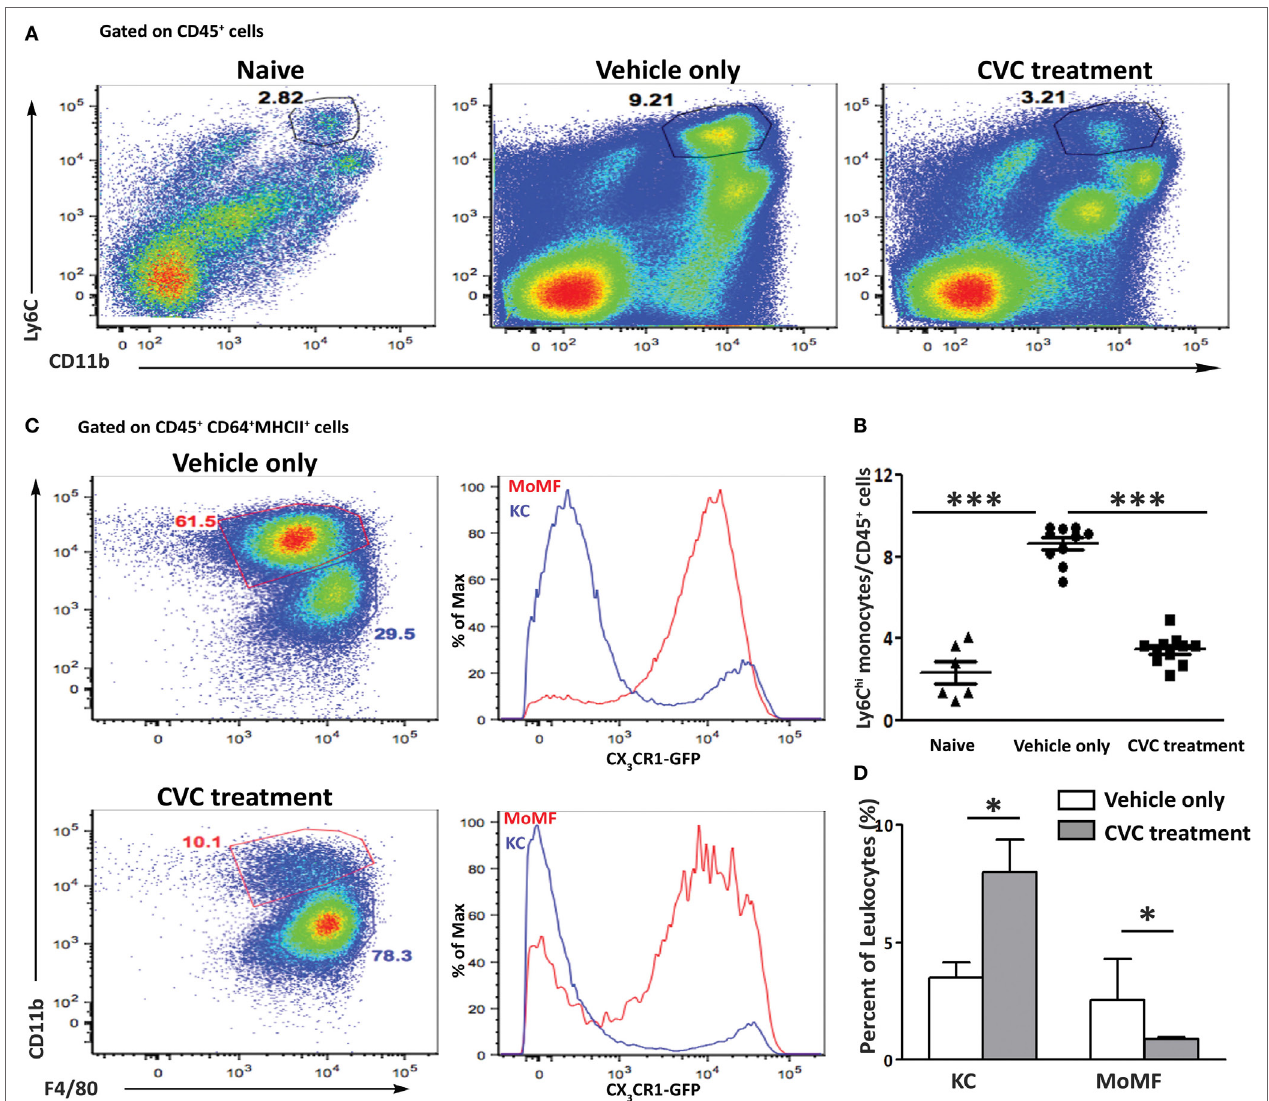
FigUre 4 | Reduced hepatic infiltration of monocyte-derived cell in CVC-treated mice subjected to the 2-octynoic acid conjugated to bovine serum albumin (2OA-BSA) autoimmune cholangitis model. (a) Representative flow cytometry analysis of non-parenchymal liver cells 8 weeks following immunization with 2OA-BSA, in indicated groups of mice. (B) Graphical summary of flow cytometry analysis shown in panel (a) . (c) Flow cytometry analysis of non-parenchymal liver cells of Cx3cr1 gfp/ + reporter mice 8 weeks following 2OA-BSA immunization treated with CVC or vehicle only. (D) Graphical summary of flow cytometry analysis of non-parenchymal liver cells of C57BL/6 mice 8 weeks post immunization with 2OA-BSA treated with CVC or vehicle only. Results are mean ± SEM ( n ≥ 10) for each group. Results are representative of two independent experiments. * p < 0.05 and *** p < 0.001 (unpaired Student’s t